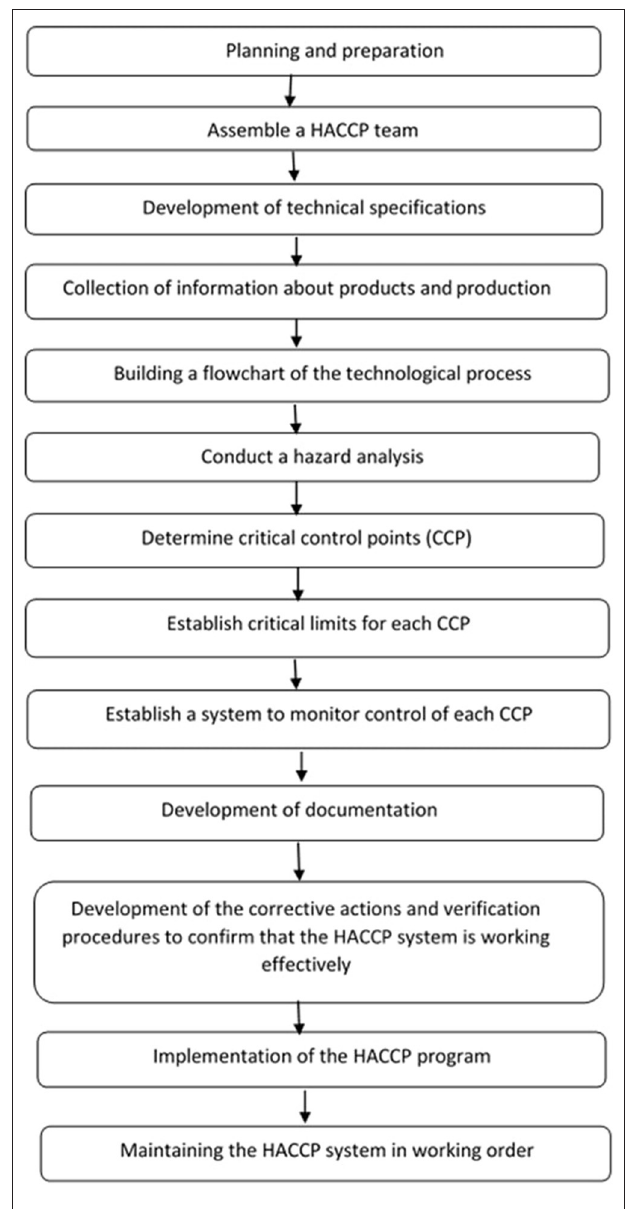
FIGURE 1 | Algorithm for implementing the principles of